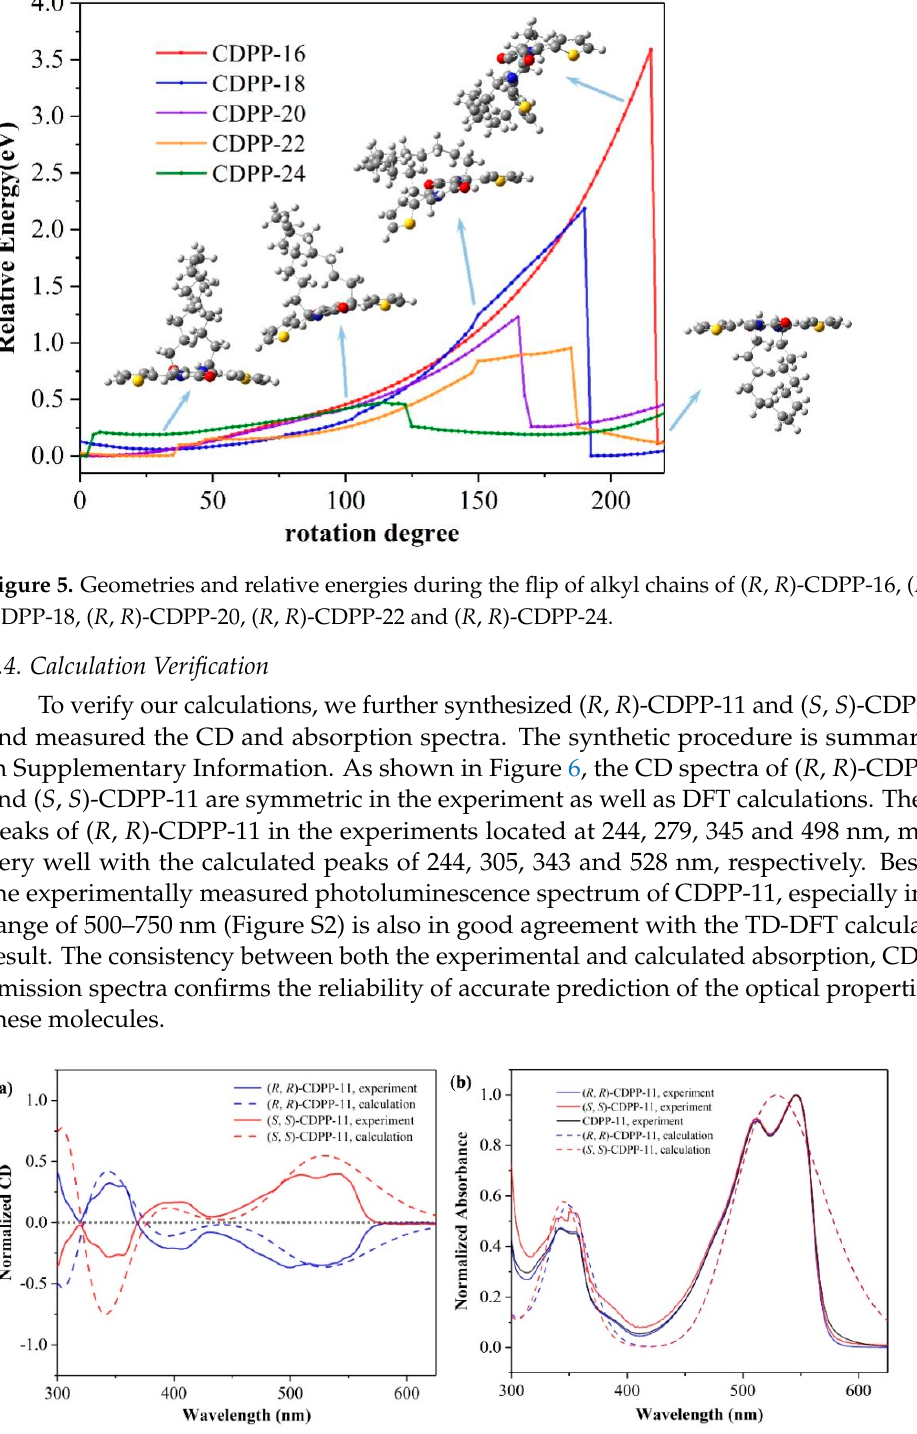
Figure 6. ( a ) Comparison between the experimental CD and calculated ECD spectra of CDPP − 11; and ( b ) comparison between the experimental and calculated normalized absorption spectra of CDPP − 11.